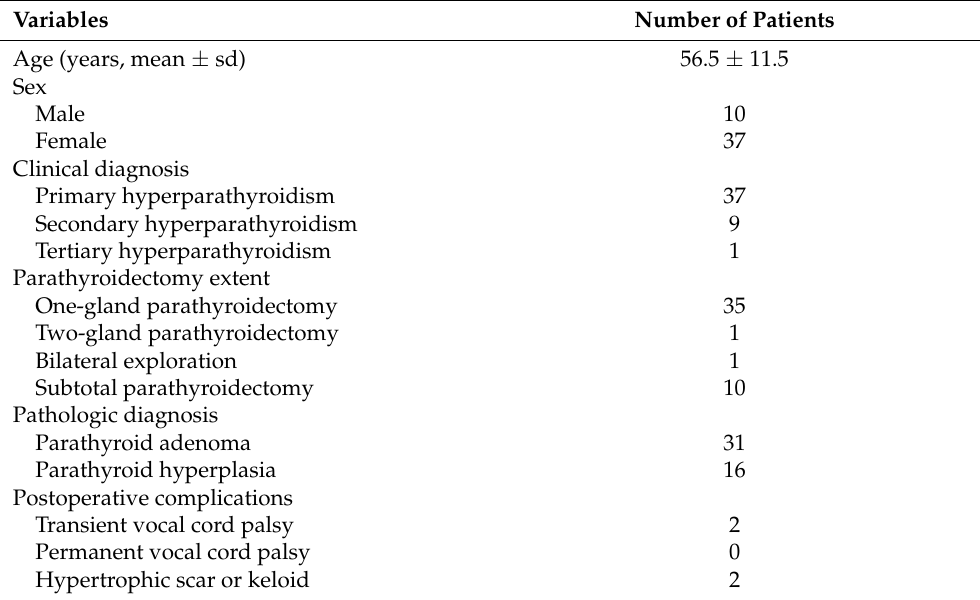
Table 1. General characteristics of all hyperparathyroidism patients (n = 47).